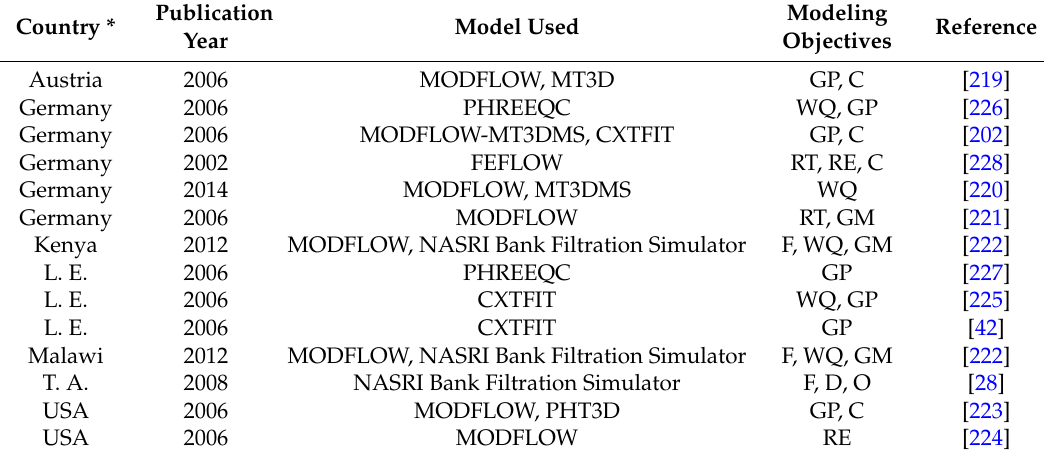
Table 5. Induced bank filtration modeling studies. The following abbreviations are used for the covered modeling objectives: Groundwater management (GM), Residence time (RT), Design (D), Feasibility (F), Recovery efficiency (RE), Water quality (WQ), Geochemical processes (GP), Clogging (C), Optimization